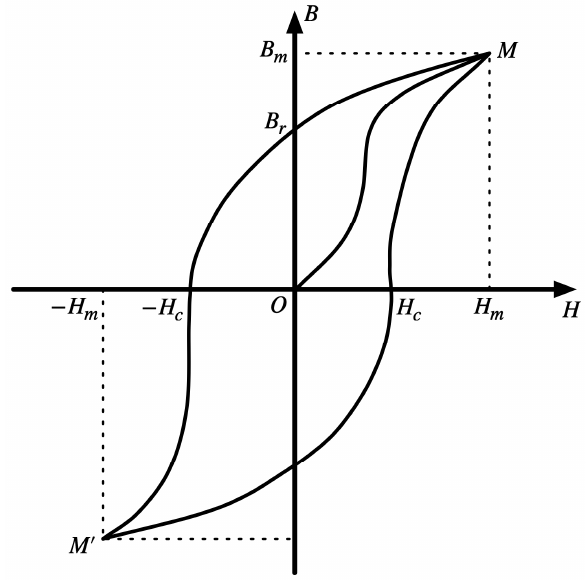
Figure 1. Structure of the three-axis magnetic fluxgate.